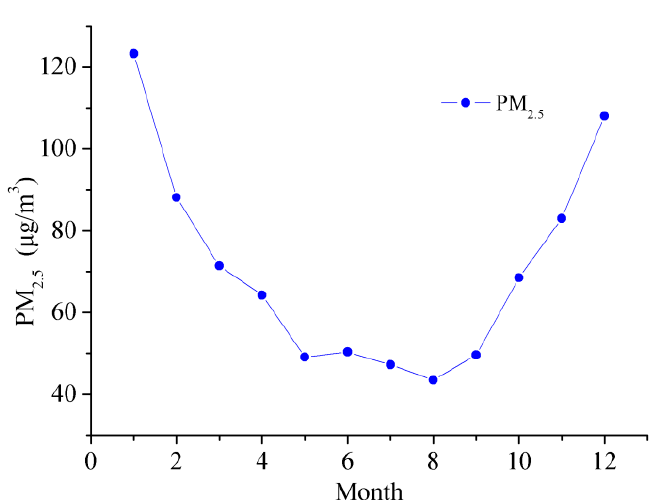
Figure 4. Monthly variation in PM 2.5 concentration in Liaocheng City from 2014 to 2021.